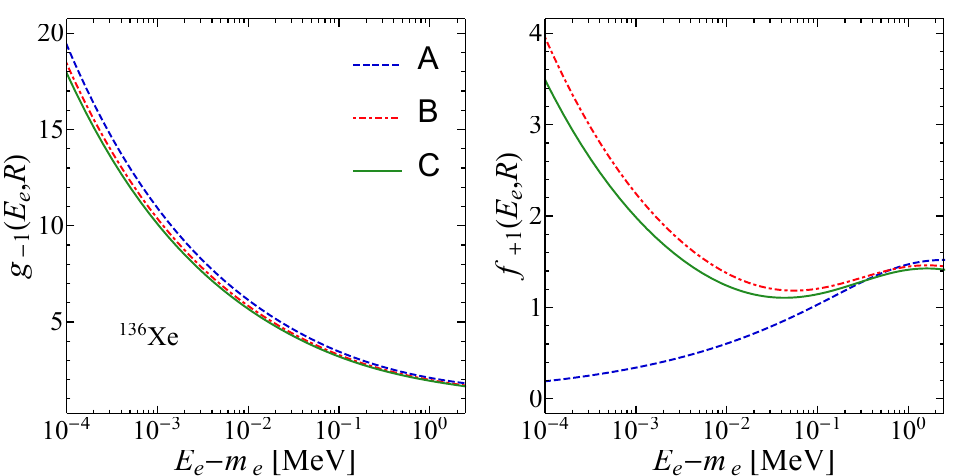
Figure 1. Electron radial wave functions in s 1/2 spherical wave state for an electron emitted in the double- β decay of 136 Xe, as functions of the kinetic energy E e − m e evaluated on the surface of the final nucleus R = 6.17